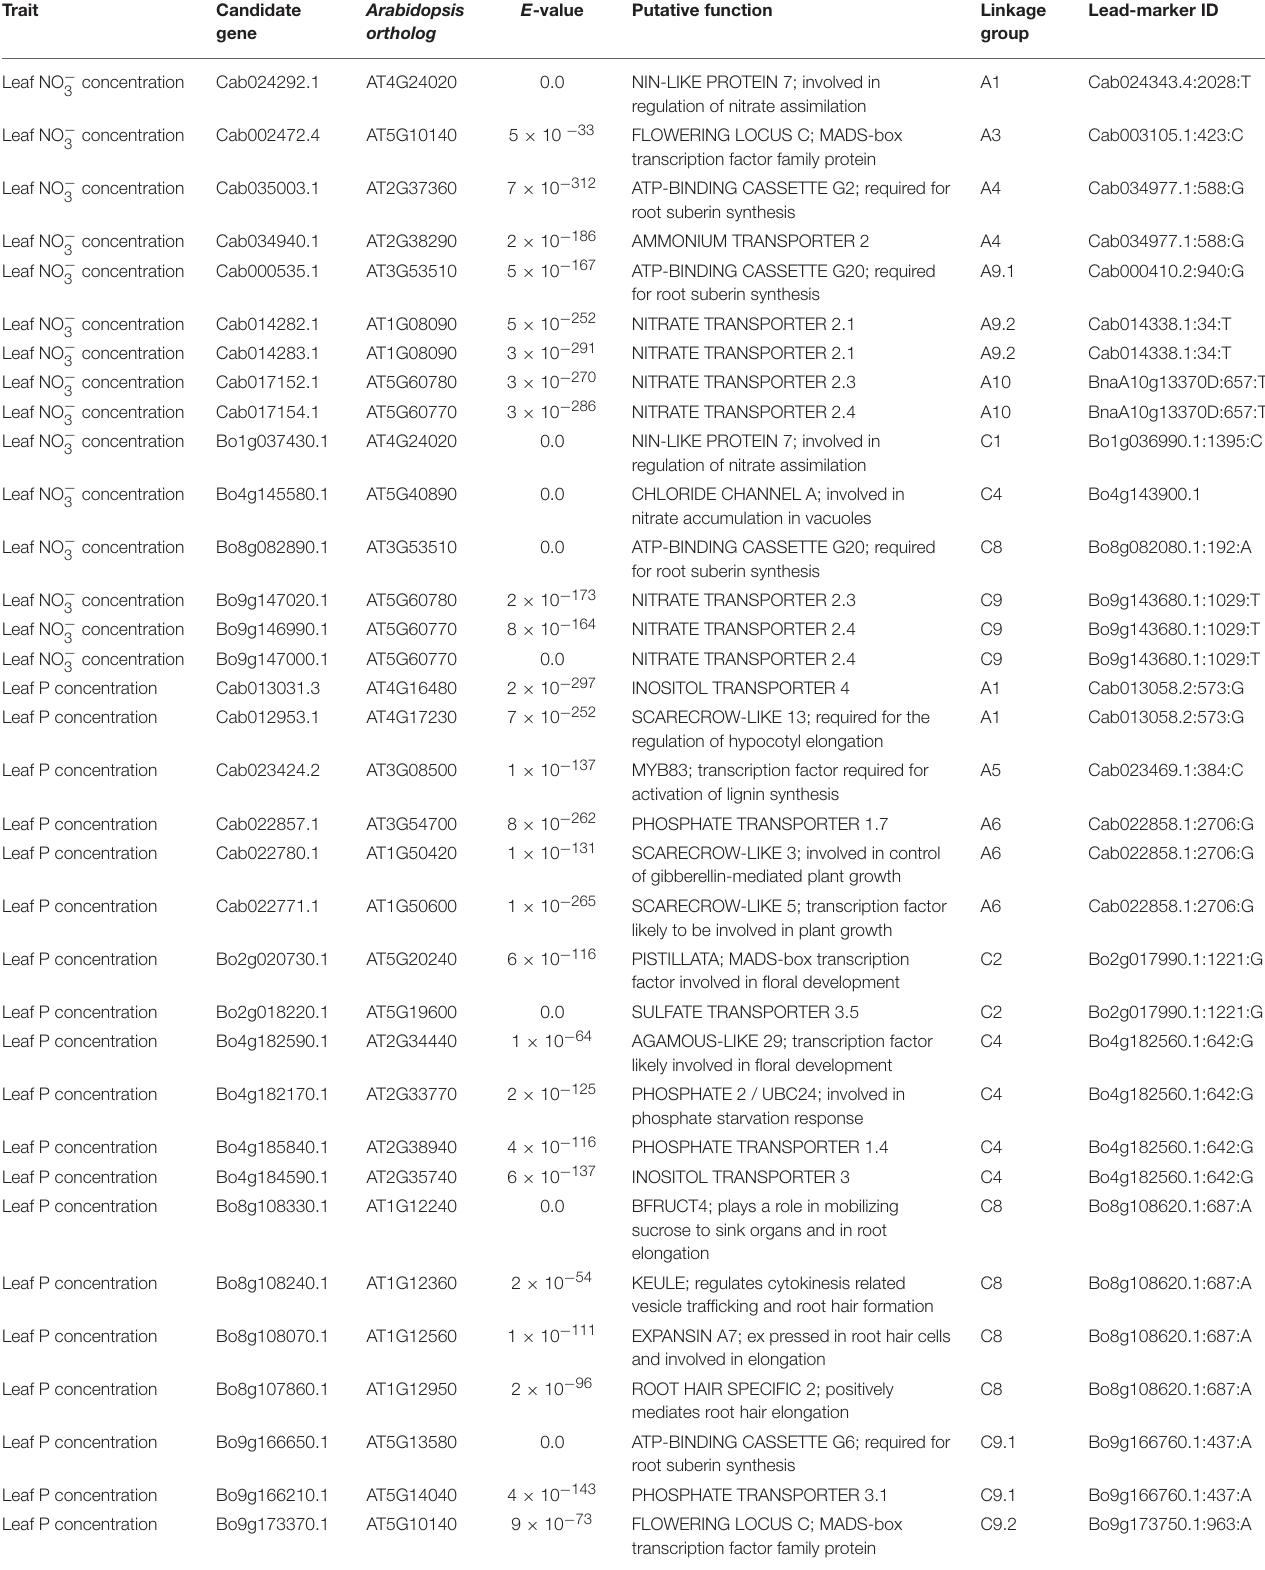
TABLE 1 | Candidate genes within estimated linkage disequilibrium decay of lead-markers associated with leaf nitrate, phosphorus, and/or potassium concentration.